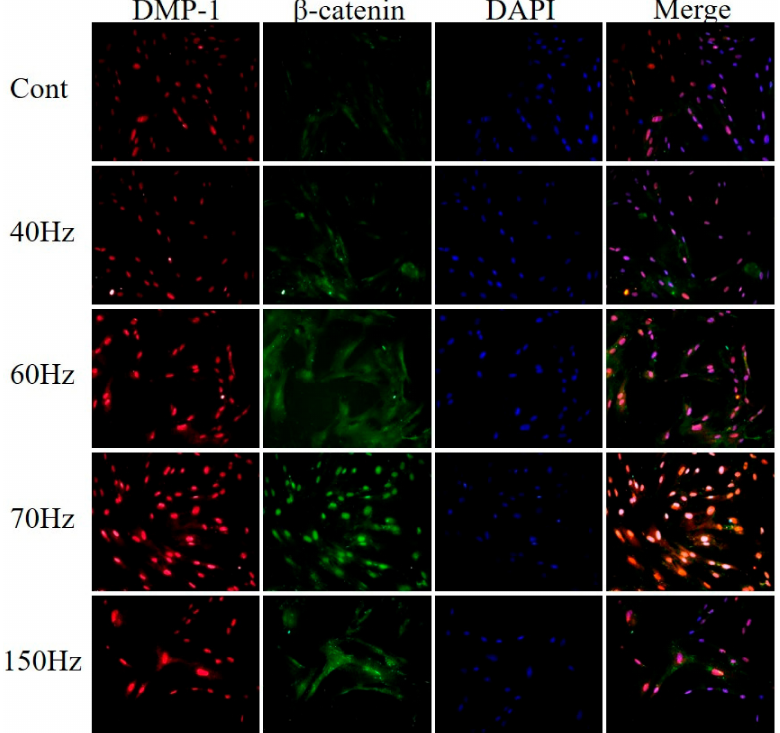
Figure 6. Effects of PEMF exposure on hDPSC odontogenesis as determined by immunofluorescence of DMP-1 and β -catenin at 5 days. DMP-1 and β -catenin expressions were visibly increased in PEMF-stimulated cells. PEMF; pulsed electromagnetic field, hDPSC; human dental pulp stem cell, DMP-1; dentin matrix acidic phosphoprotein 1. Cont = control (no PEMF treatment).